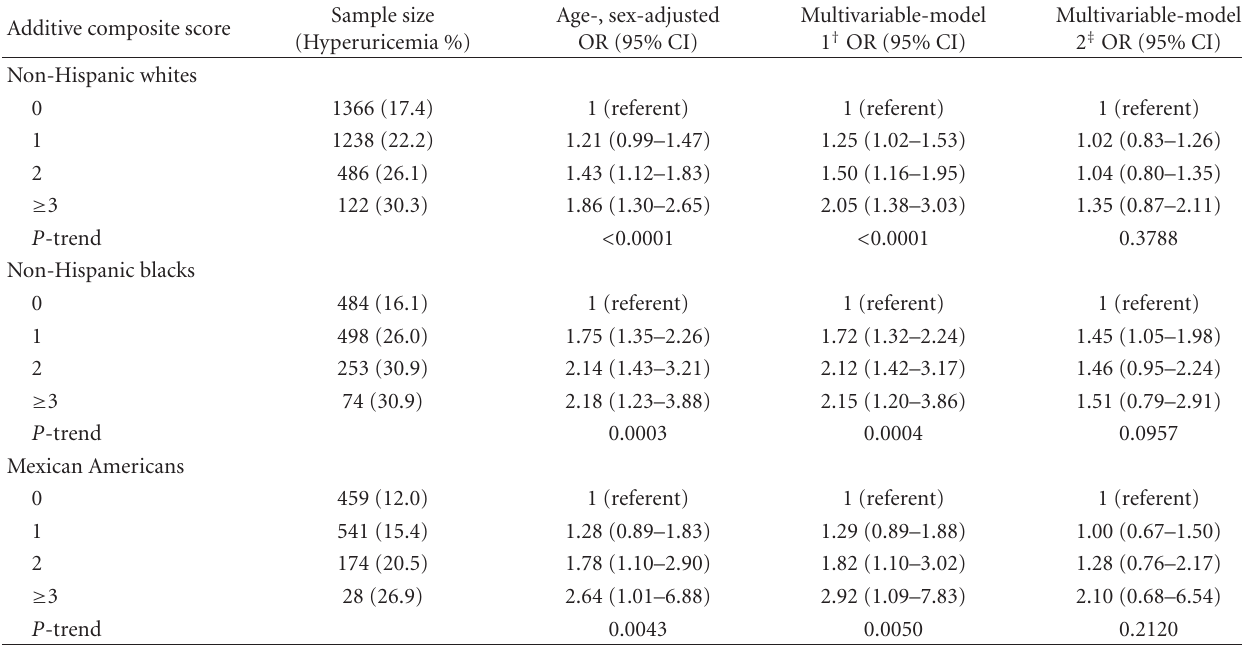
Table 4: Association between sleep variables and hyperuricemia, by race/ethnicities ∗